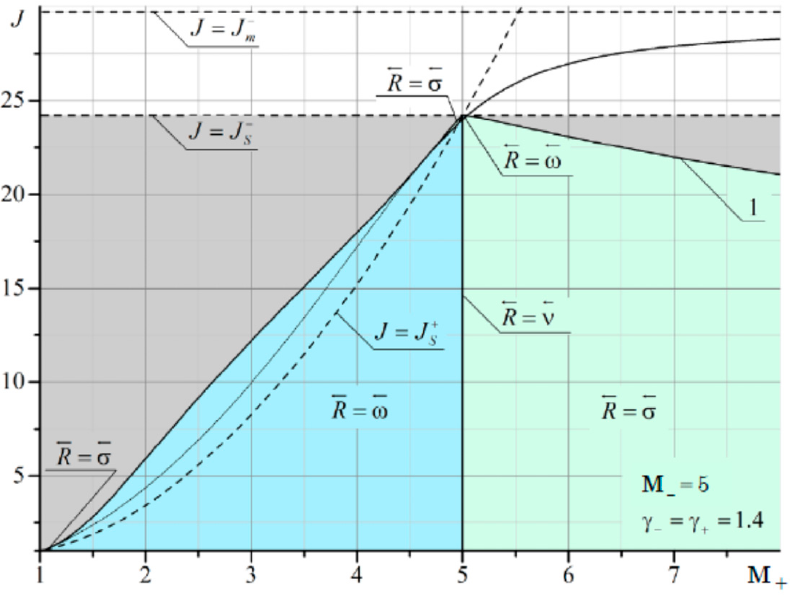
Figure A9. Domains of existence of reflected discontinuities for refraction in a flow of diatomic gas. The Mach number of the flow from which the shock comes is M – = 5. The domains of existence of reflected discontinuities for refraction from a monatomic gas into a gas consisting of combustion products at the Mach number of the flow M – = 2 are shown in Figure